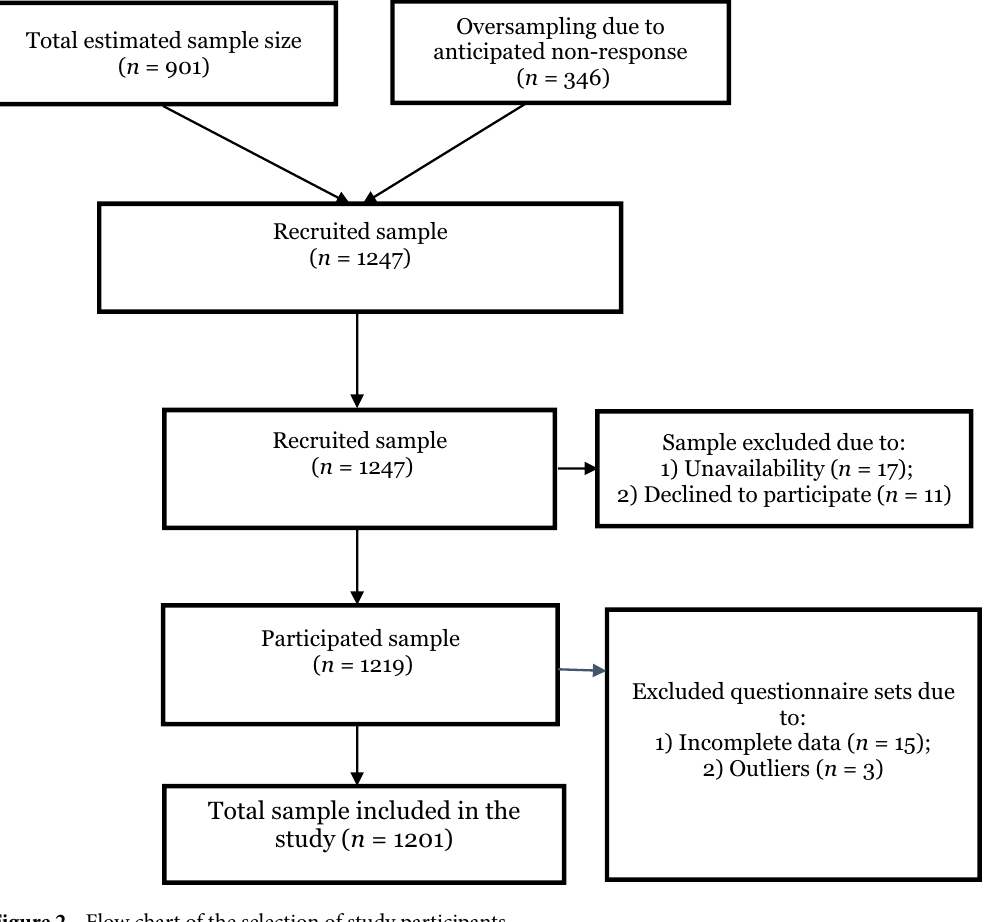
Figure 2. Flow chart of the selection of study